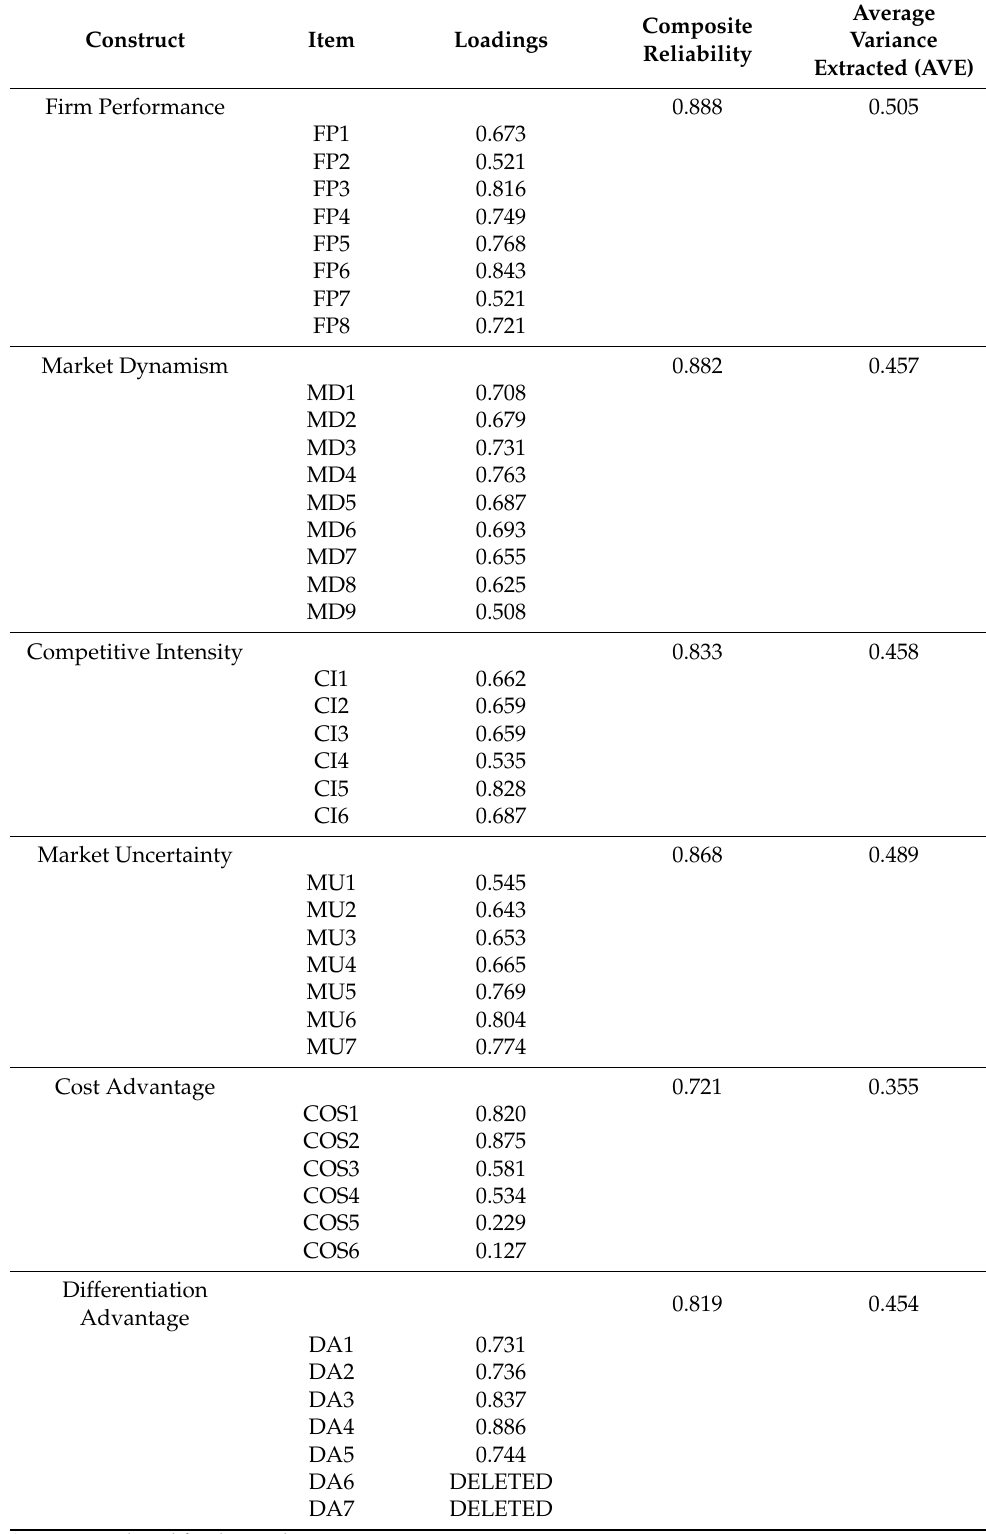
Table 2. Convergent